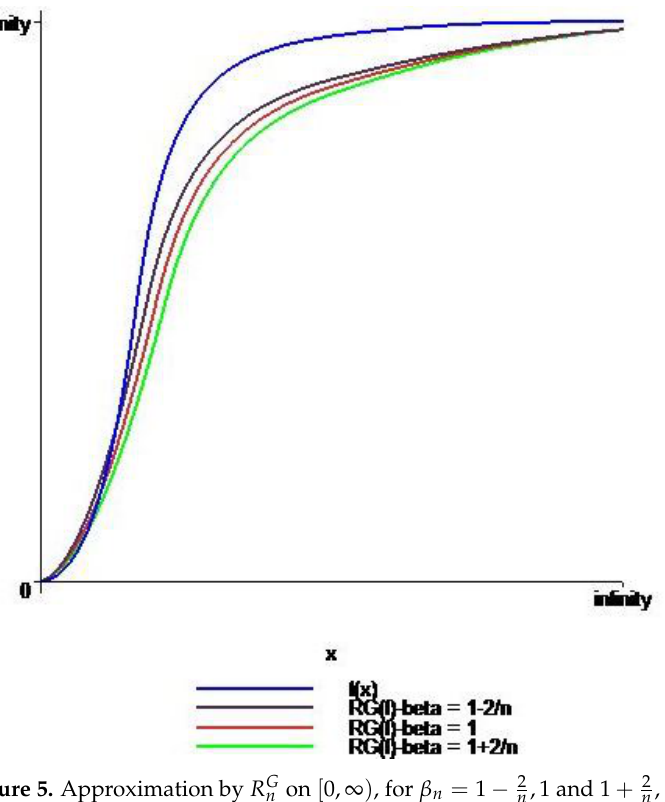
Figure 5. Approximation by R G n on [ 0, ∞ ) , for β n = 1 − 2